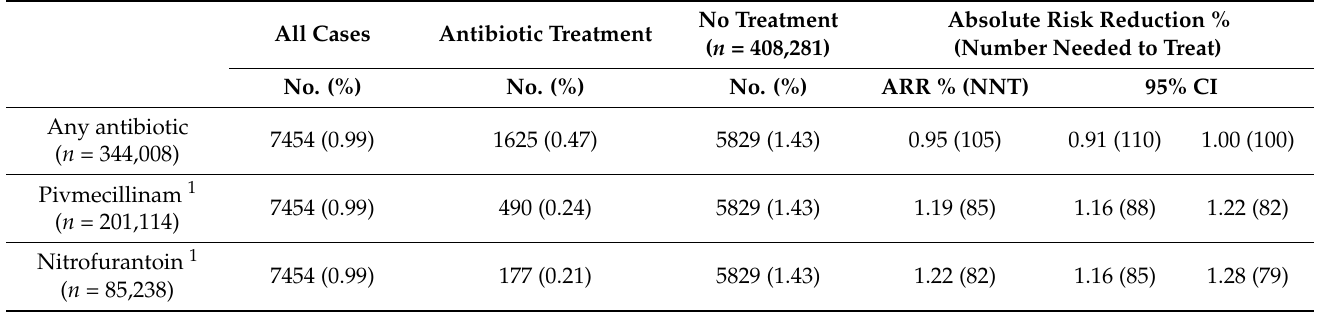
Table 2. The 30-day crude risk of acute outpatient pyelonephritis in women with acute uncomplicated